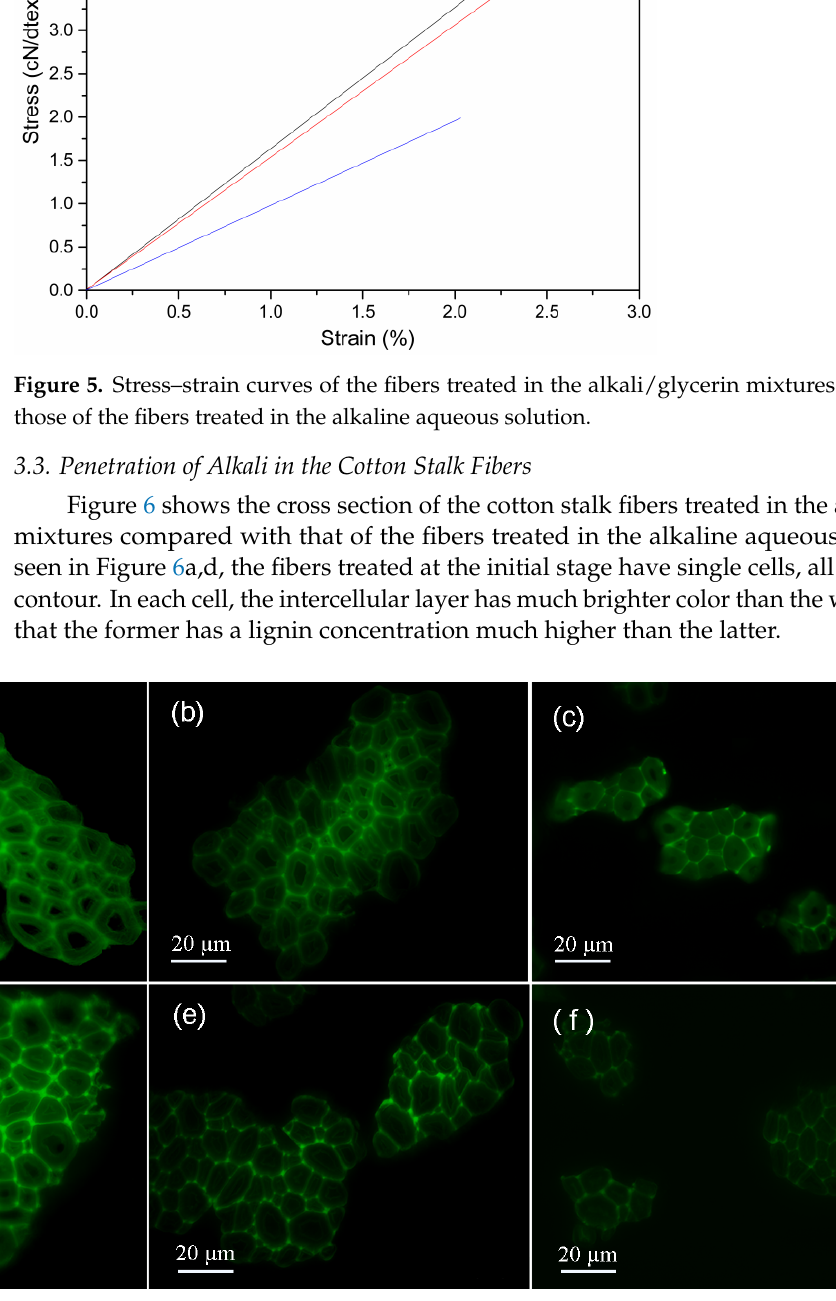
Figure 4. Schematic diagram of the limited alkali penetration in cotton stalk fibers.